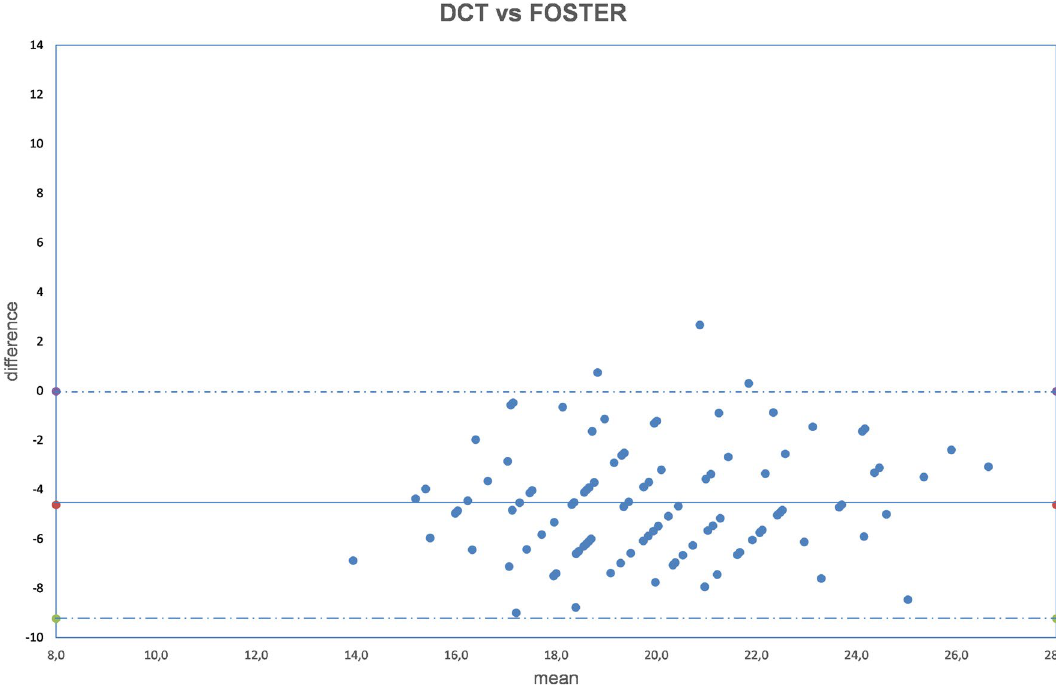
Figure 11. Bland–Altman plot between IOP measured with DCT and GAT corrected with Foster formula. Dashed line: mean difference. Dash-dotted lines: mean difference (− 4.63 mmHg) ± 2 standard deviation (2.30 mmHg) of the